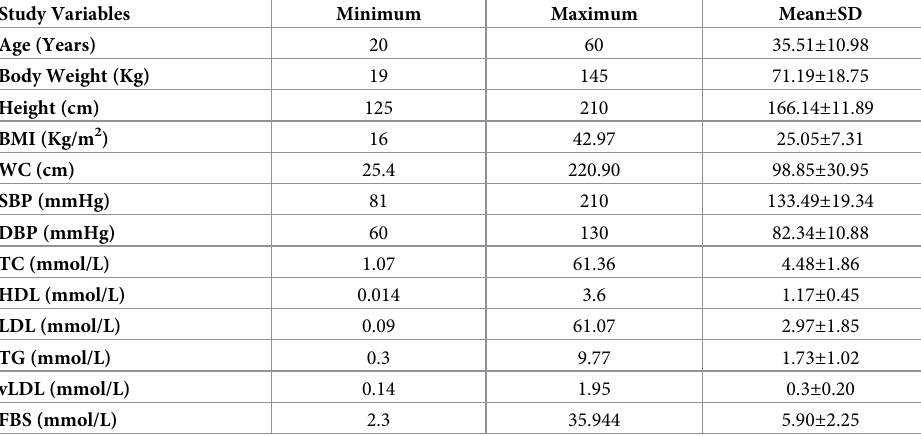
Table 1. Descriptive statistics of study